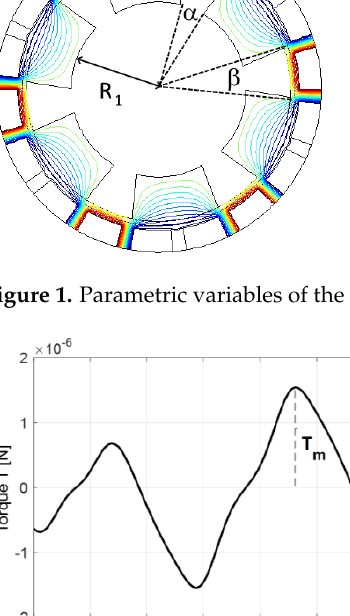
Figure 1. Parametric variables of the electrocstatic motor.